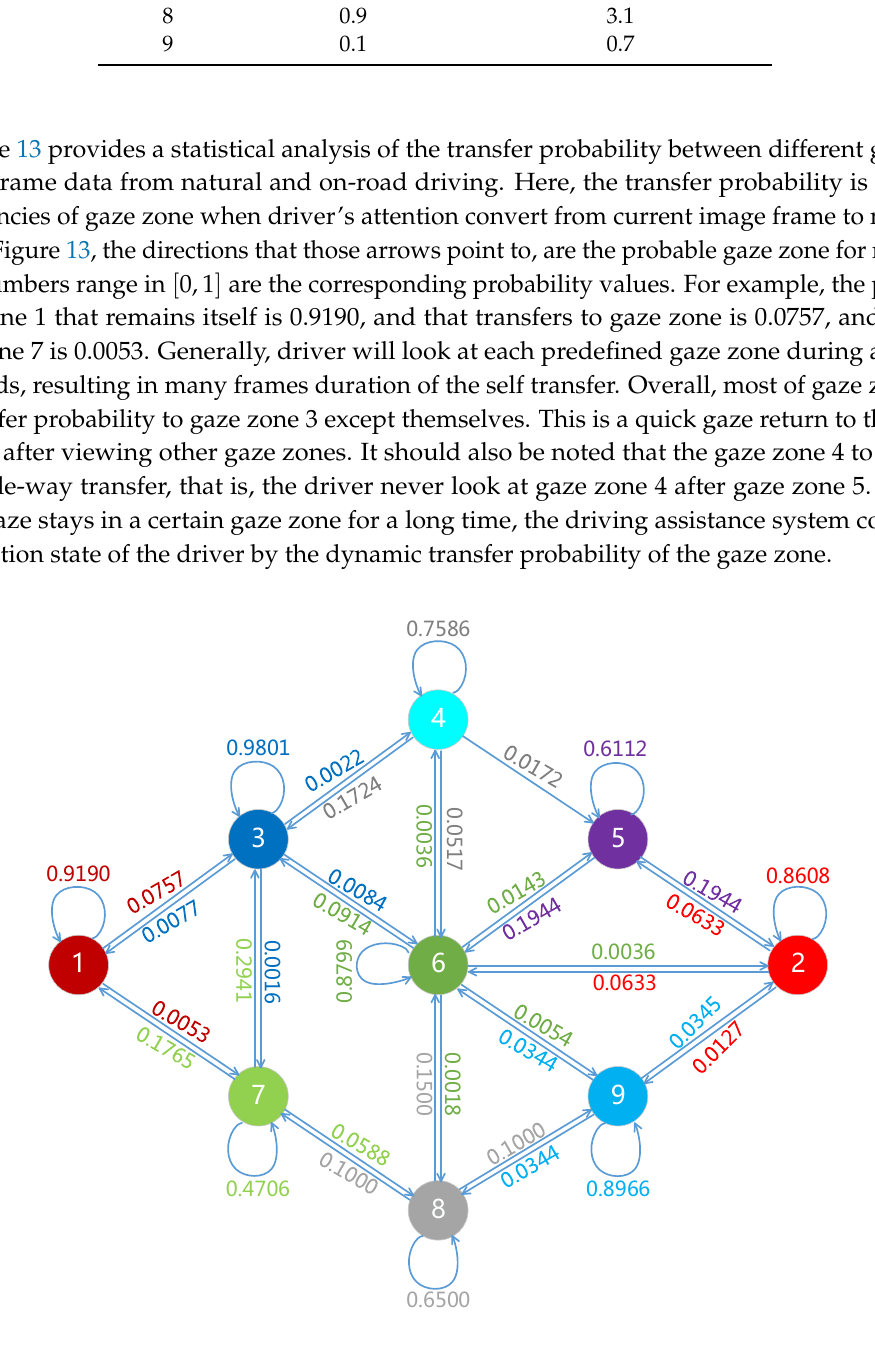
Figure 13. Transfer probability between different driver gaze